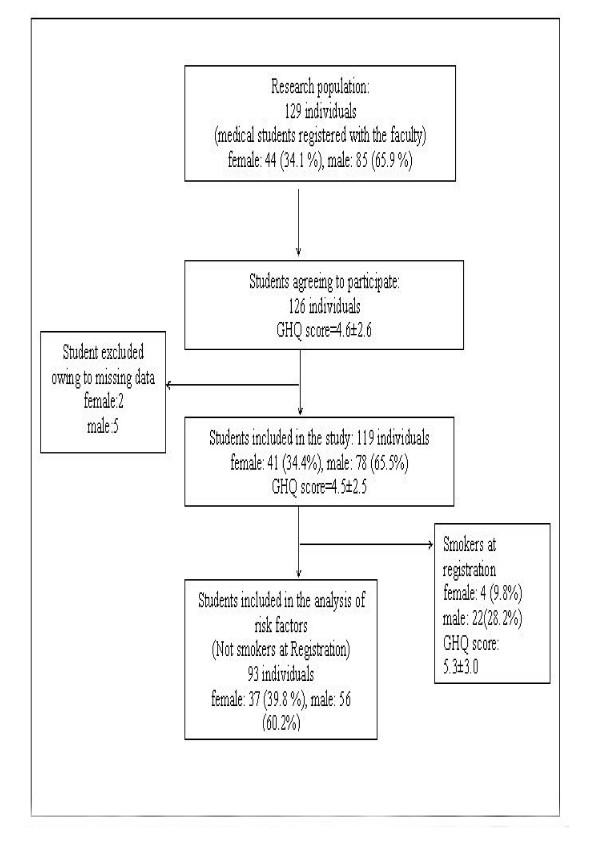
Design of the study.